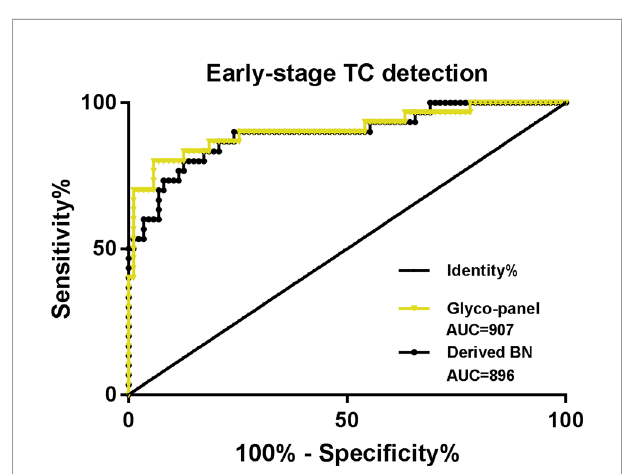
FIGURE 6 | ROC curve analysis for derived glycan trait BN and the established glyco-panel in detecting early-stage thyroid cancer